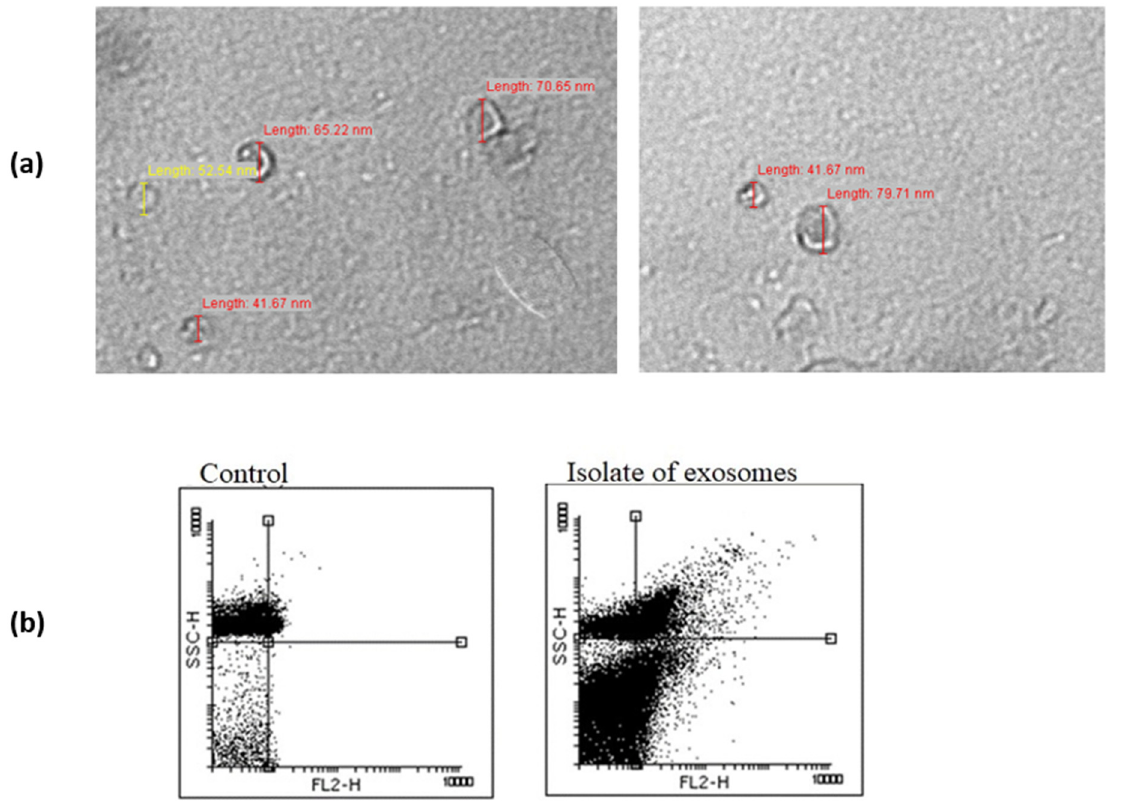
Figure 1. ( a ) Transmission electron microscopy (TEM) of exosomes. The observed appearance of EVs corresponds to the morphology and size range of exosomes. ( b ) Flow cytometry analysis detected the expression of the surface protein marker of exosomes, CD9.